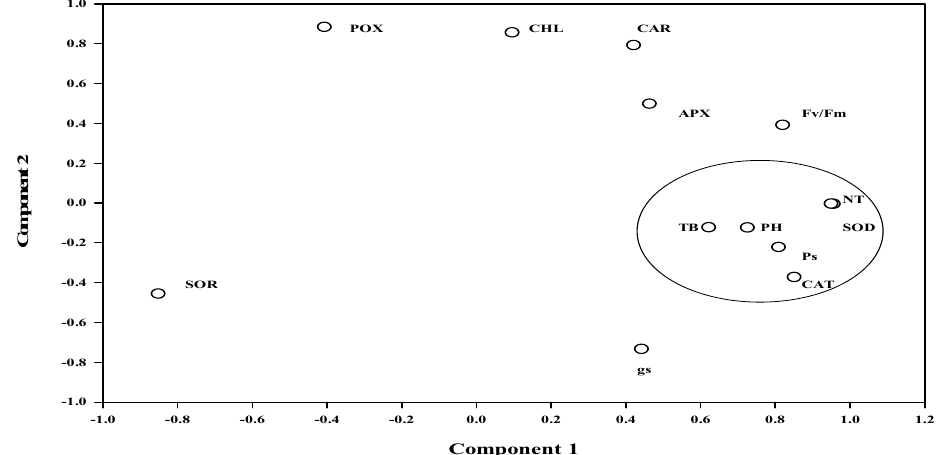
Figure 3. Yield (weight of grains per plant) of three wheat cultivars as affected under EDU treatment. Values are mean ± SE; n = 9. Symbols above the bars represent significant variability between EDU- and non-EDU-treated plants. The one, two and three asterisks indicate the significance levels at *p ≤ 0.05, **p ≤ 0.01, and ***p ≤ 0.001, and ns is non-significant. Significant variations between cultivars under EDU and non-EDU treatment are respectively represented by different capital and small letters ( p < 0.05).